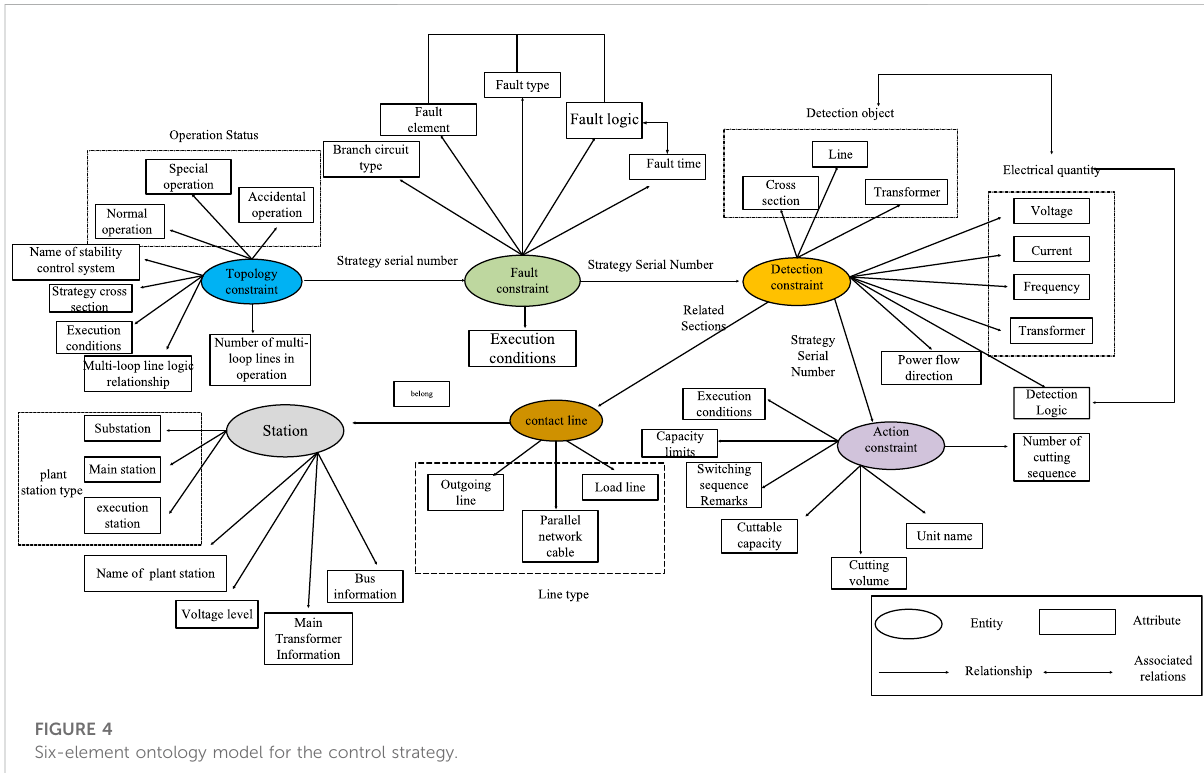
FIGURE 4 Six-element ontology model for the control